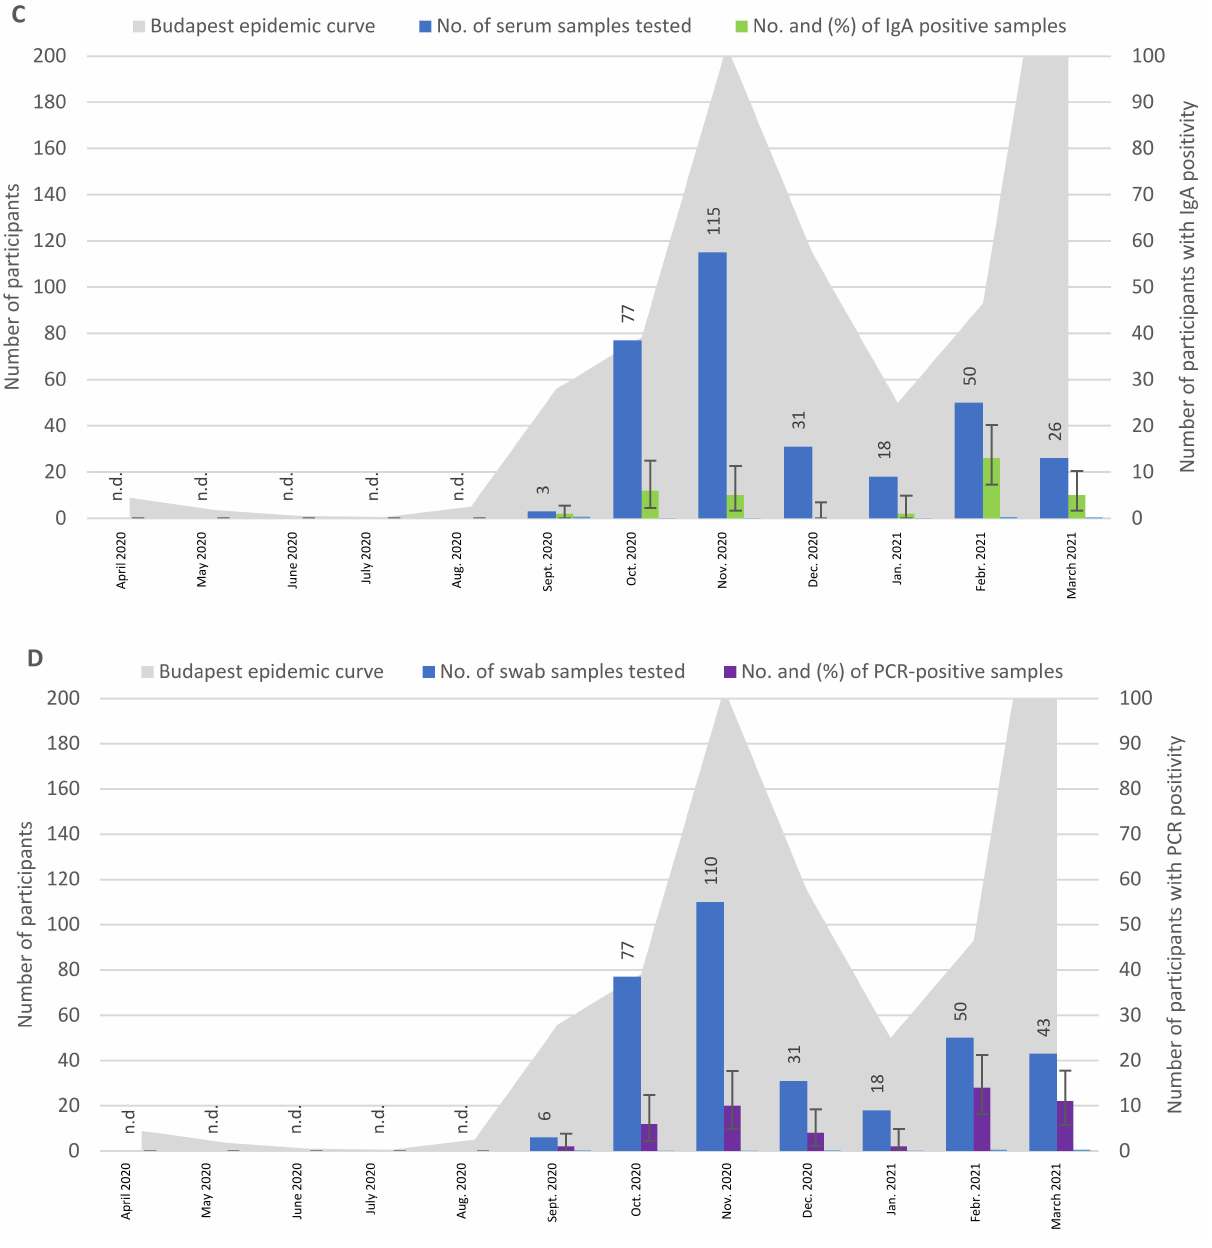
Figure 2. Monthly distribution and results for samples obtained from participants with known COVID-19 contacts. The participants were investigated for IgG and IgA antibodies using ELISA, for symptoms using a questionnaire, and for the presence of SARS-CoV-2 RNA in nasopharyngeal swab samples using RT-PCR. ( A ) Monthly distribution of participants with COVID-19 symptoms. ( B ) Monthly distribution of serum samples tested for IgG results. ( C ) Monthly distribution of serum samples tested for IgA results. ( D ) Monthly distribution of swab samples and PCR results. “n.d.”—not